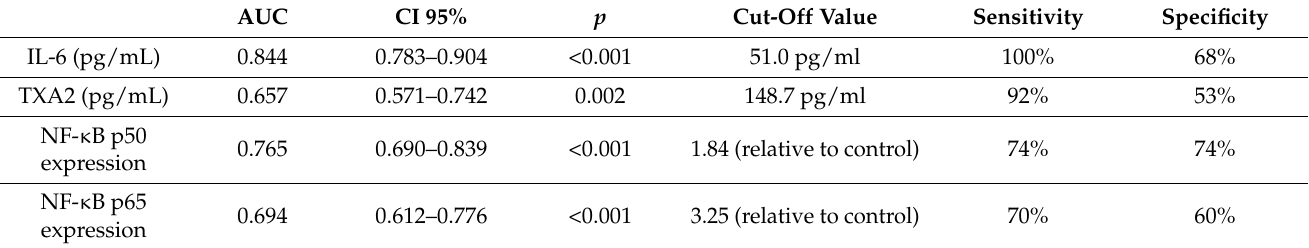
Table 7. AUC, sensitivity and specificity calculation for IL-6, TXA2, NF- κ B p50, and NF- κ B p65 in severe